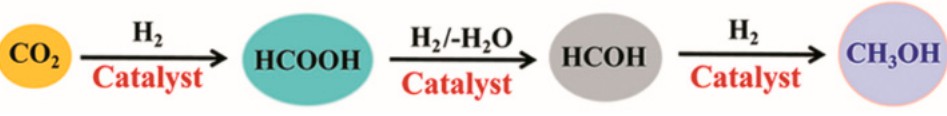
Figure 1. The three continuous catalytic processes of CO 2 hydrogenation to methanol.